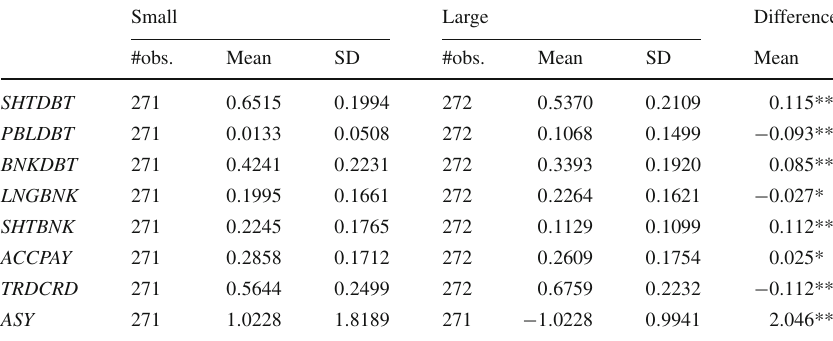
Table 5 Differences between small and large